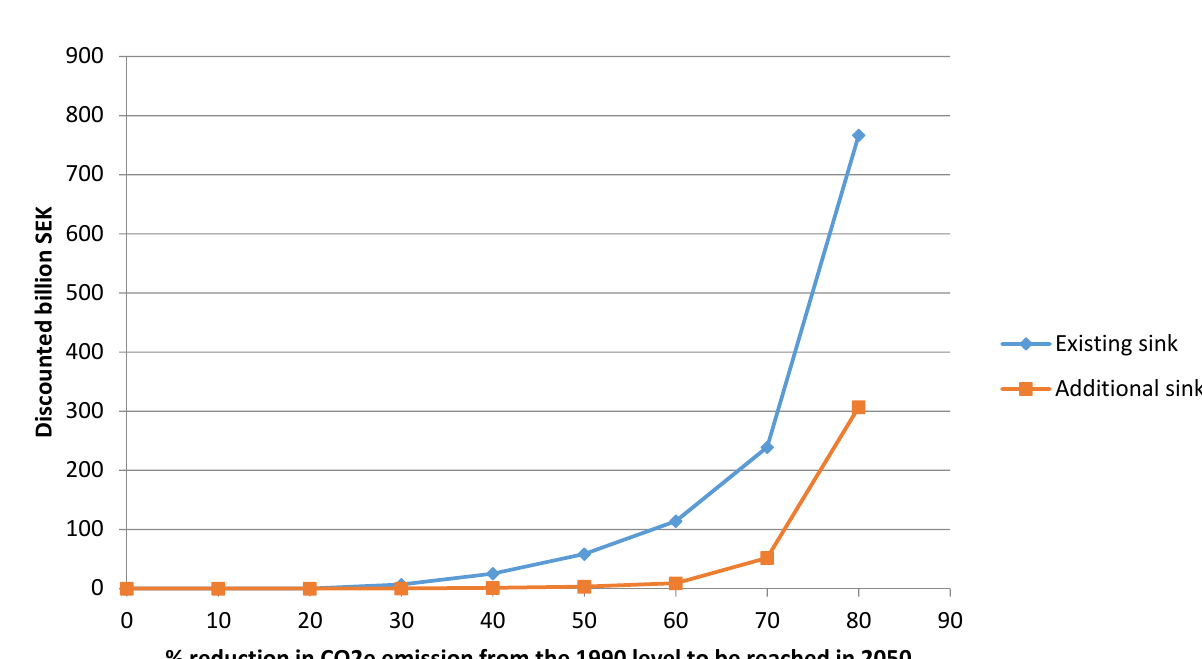
Figure 2. Value of forests for carbon sequestration when only existing or additional carbon sinks are included at different reduction levels from the 1990 emission, to be achieved by